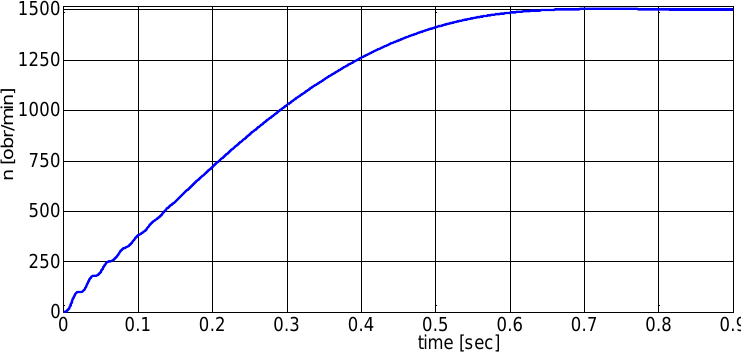
Figure 8. Rotational speed waveform of a solid-rotor induction motor.